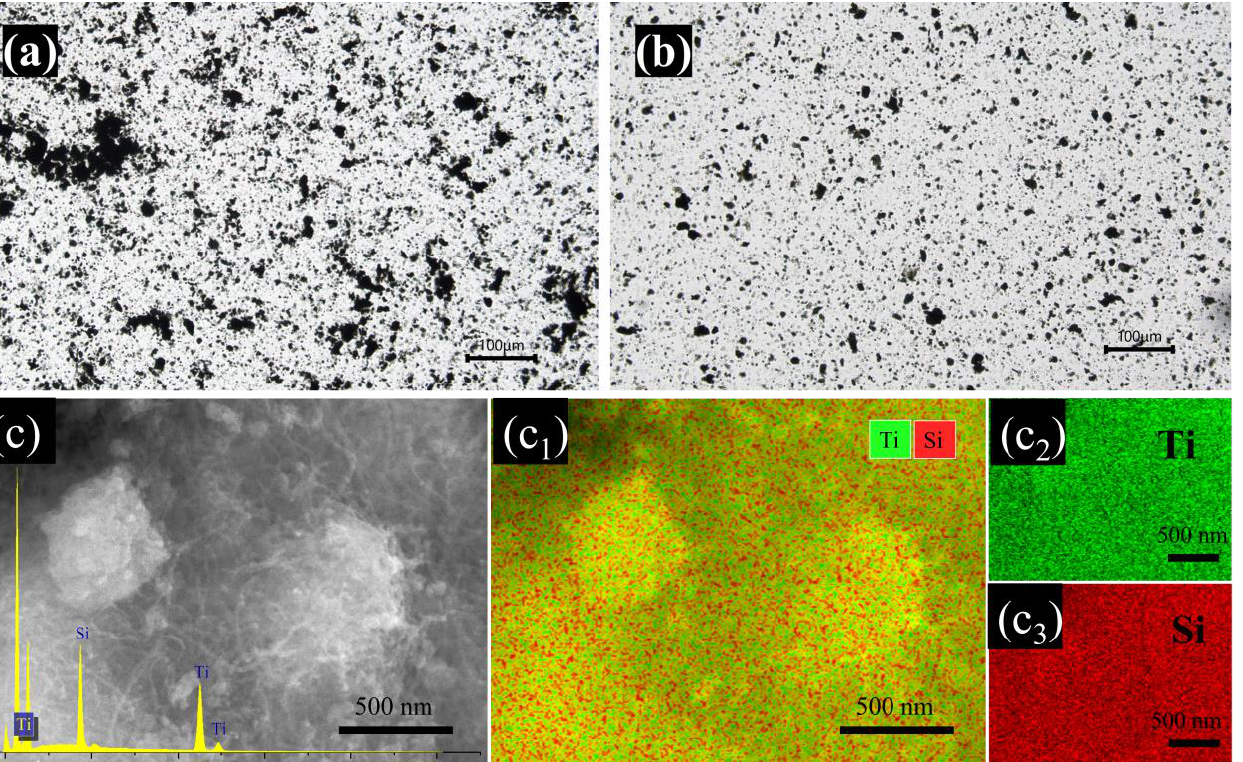
Figure 6. Metallographic microscopic photographs of unmodified CNT ( a ) and CNT MO ( b ) in SPU resin; EDS ( c ) and elemental mapping of CNT MO ( c1 – c3 ).